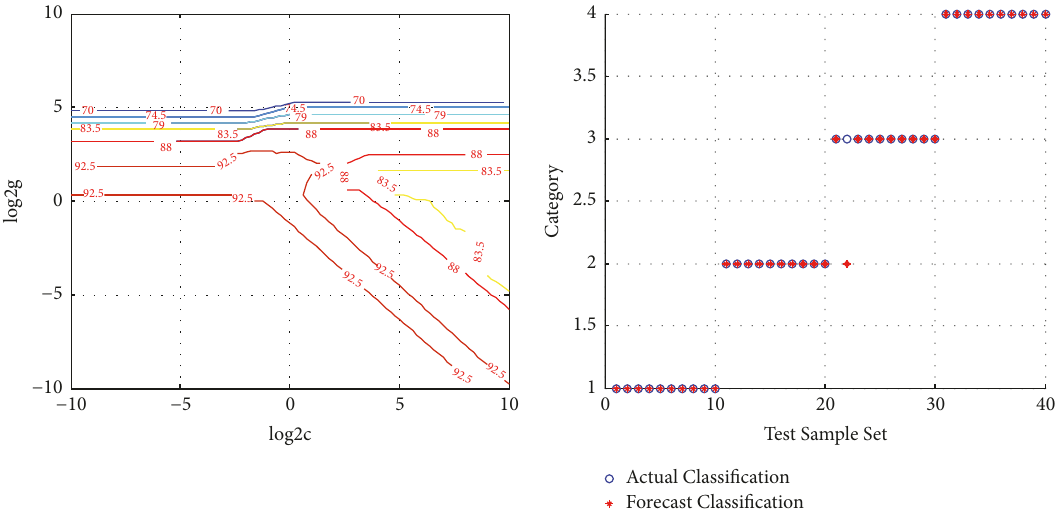
Figure 14: Classification training and test results based on grid method.